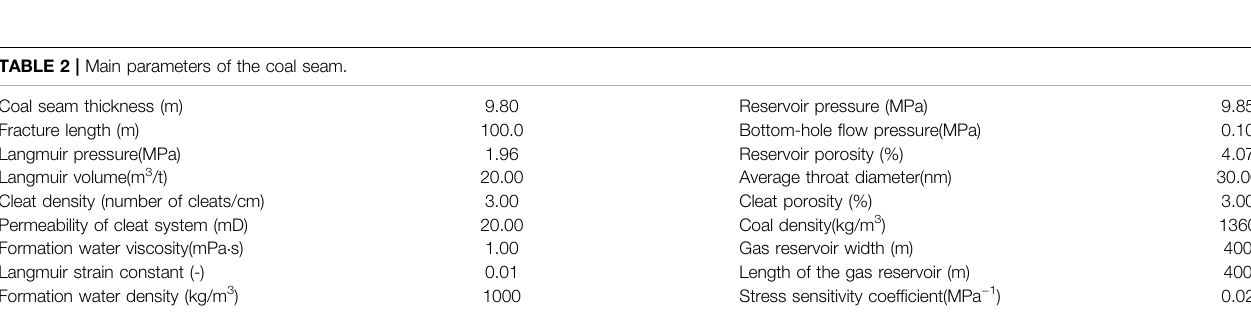
TABLE 2 | Main parameters of the coal seam.